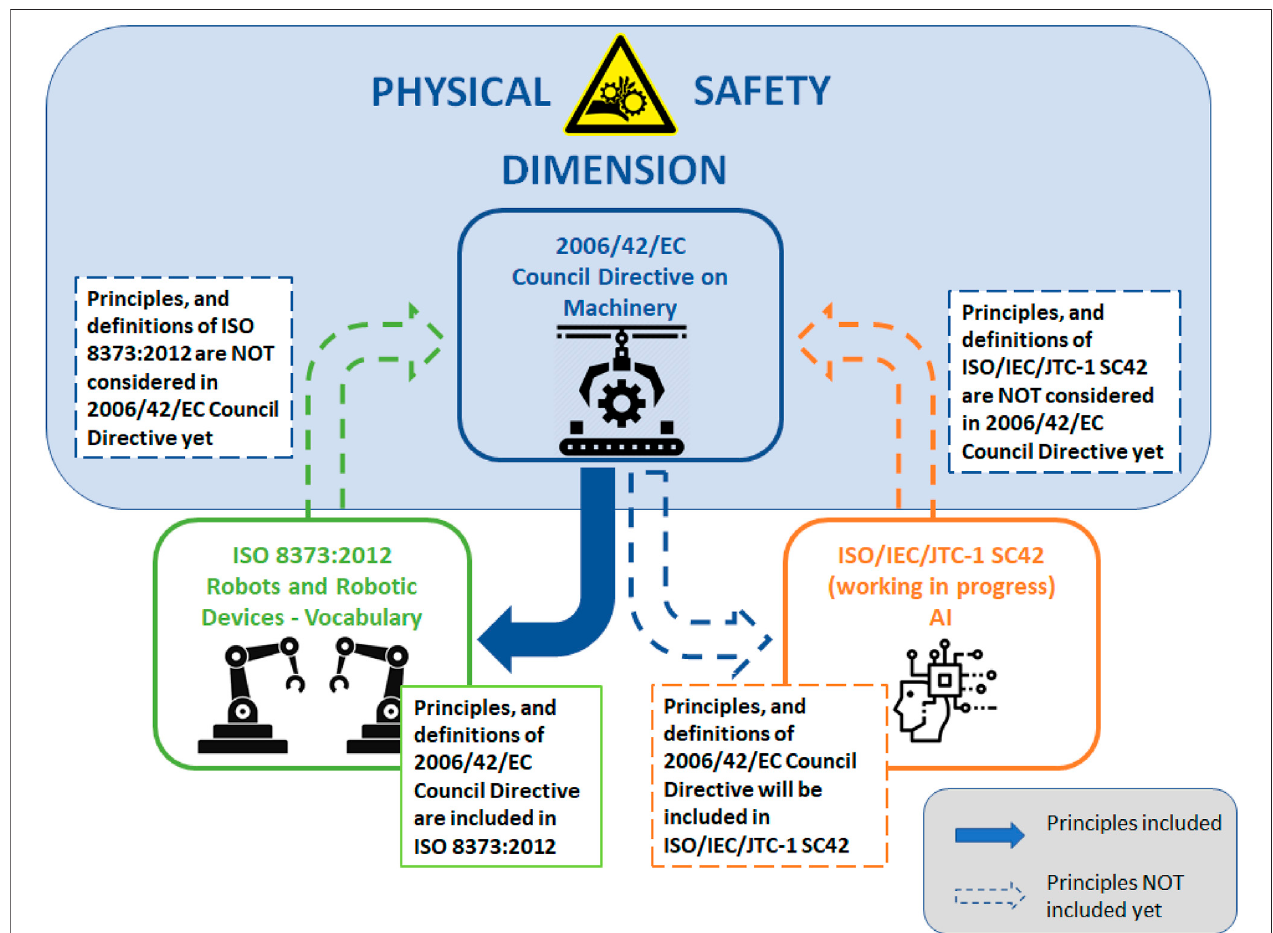
FIGURE 2 | Relation between machinery, robot/collaborative robot and AI from a regulation perspective.